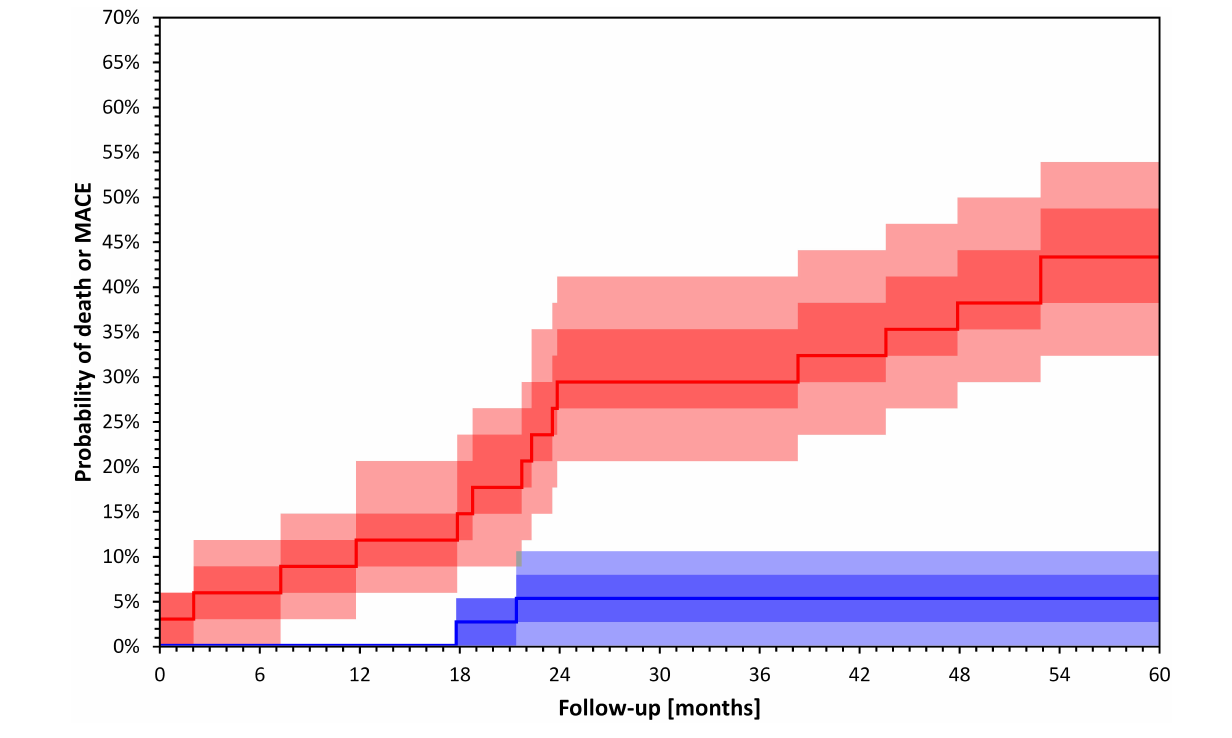
FIGURE 3 | Kaplan–Meier survival curves of total mortality and major cardiac events in 72 HD patients included in a recently published study (Poulikakos et al., 2018) stratified by LF/HF above (blue) and below (red) median value ( p = 0.001 Log Rank test). Darker bands depict interquartile ranges and the lighter bands ranges between 10th and 90th percentiles. The calculation of confidence intervals was performed using bootstrap 10,000 repetitions. Major cardiac events were defined as sudden cardiac death, acute coronary syndrome, coronary revascularization or admission due to heart failure or